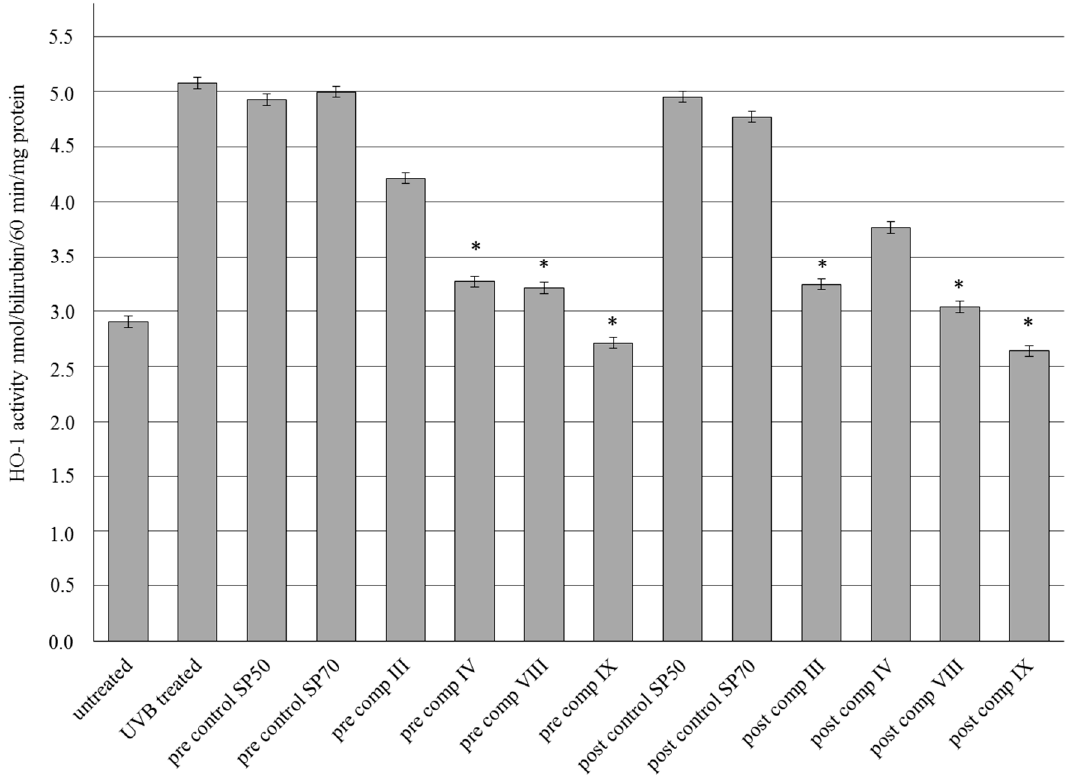
Figure 7. Effects of topical formulations containing silymarin in pre- and post-treatment on HO-1 enzyme activity in dorsal skin tissue homogenate of guinea pig induced by UV-B irradiation. HO-1 activity is expressed in nmol/bilirubin/60 min/mg protein. Bars represent means ± S.D., n = 5. In case of HO-1 evaluations Repeated-Measures ANOVA and Pearson correlation tests were performed. Significant differences compared to the untreated control are marked with * in the figures.